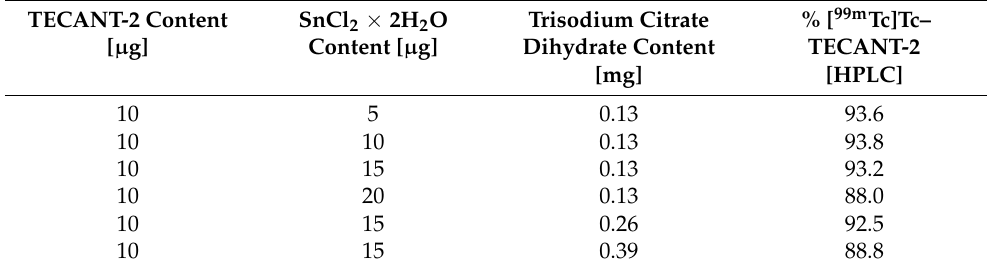
Table 3. Summary of initial 99m Tc-labelling experiments: influence of SnCl 2 × 2H 2 O and trisodium